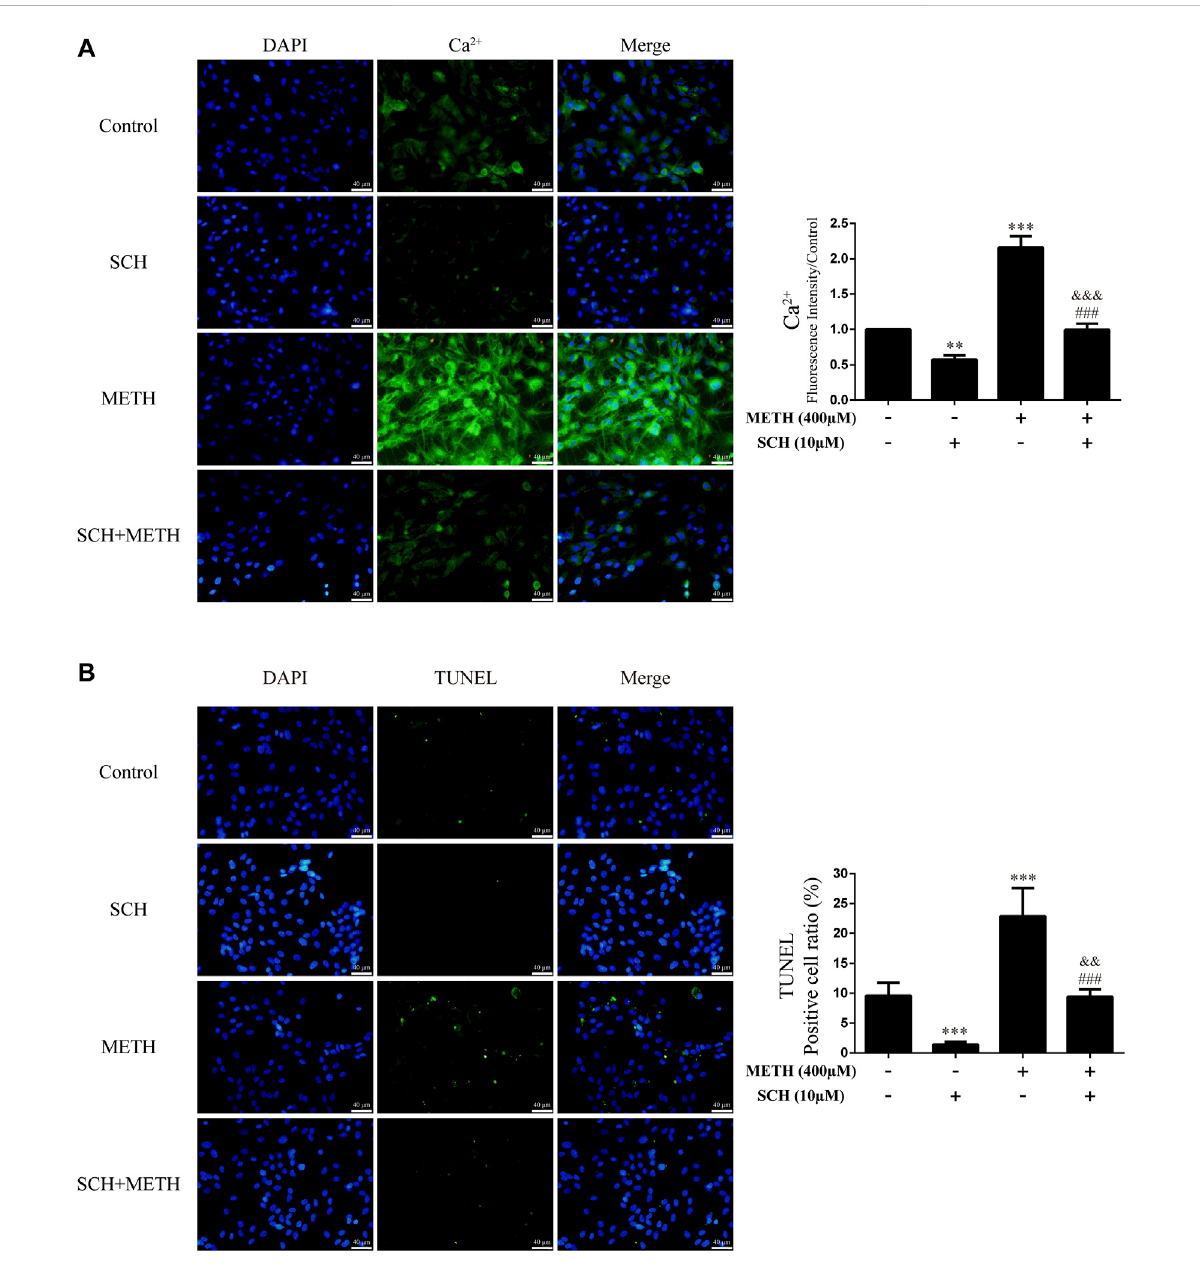
FIGURE 6 Intracellular Ca 2+ and apoptosis levels in neurons incubated with SCH23390 and/or METH. (A) Apoptosis level in neurons. (B) Intracellular Ca 2+ level in neurons. ** p < 0.01 or *** p < 0.001 compared with control group, ### p < 0.001 compared with METH group, && p < 0.01 or &&& p < 0.001 compared with SCH23390 group; Tukey HSD post-hoc comparison after signi fi cant